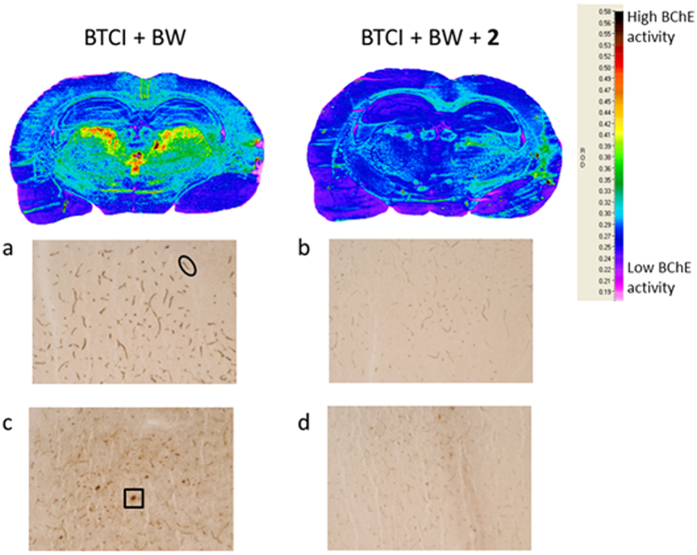
Inhibition of BChE in rat brain slices.Representative coronal section from a rat brain in the region of the thalamus processed for BChE histochemical staining using 4 mM butyrylthiocholine iodide (BTCI), in the absence (left) and presence (right) of 300 μM compound 2. Here, 10 mM BW-284C51 (BW) was added to completely block AChE activity. Vascular structures in the cortex (black oval highlight) and BChE-rich neurons in the laterodorsal thalamic nucleus (black box highlight) in the absence (a,c) (respectively) and presence (b,d) (respectively) of compound 2. Magnification, 10×. The relative optical density (ROD) scores for the staining intensity for BChE activity are shown on the right.